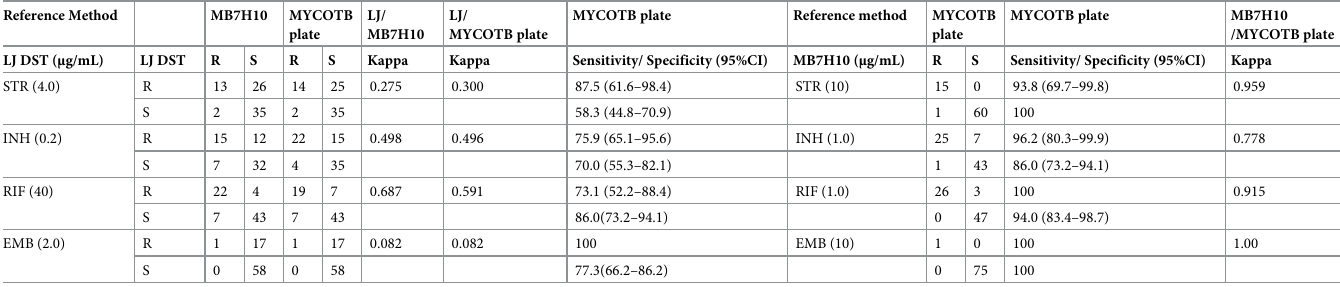
R = resistant, S = Susceptible, CI = confidence interval, LJ = Lowenstein Jensen, MB = Middlebrook, MYCOTB = sensititre MYCOTB plate, STR = streptomycin, INH = isoniazid, RIF = rifampicin, EMB = ethambutol